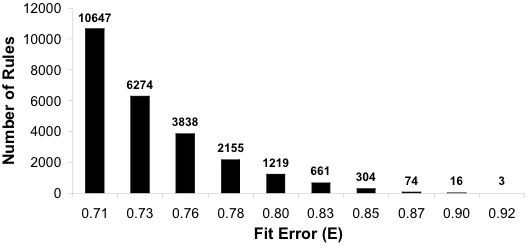
Fuzzy Rule Search Convergence. Histogram of the number of fuzzy rules for CLN1 expression at different fit error (E) levels.